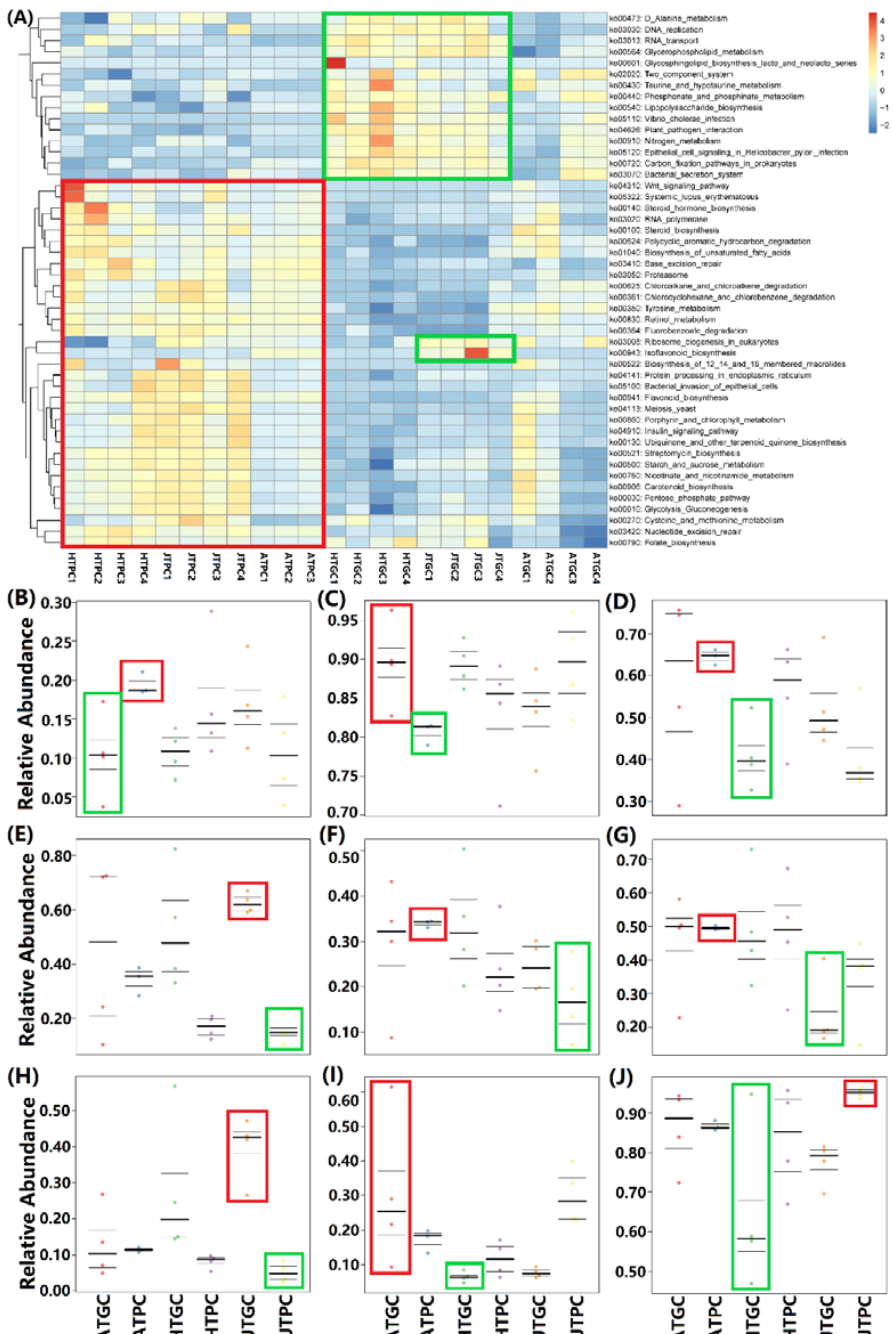
Figure 5. Kyoto Encyclopedia of Genes and Genomes (KEGG) pathway annotation information and prediction of bacterial phenotype of PC and GC groups. ( A ): KEGG pathway annotation, the red and green boxes represent the high abundance of PC and GC environments. The black boxes represent the high abundance of the HTPC group, the blue boxes represent the high abundance of the JTPC group, and the red boxes represent the high abundance of the HTGC group. The green boxes represent the high abundance of the JTGC group, and the gray boxes represent the high abundance of the ATGC group. ( B ): Gram Positive; ( C ): Gram Negative; ( D ): Biofilm Forming; ( E ): Pathogenic Potential; ( F ): Mobile Elements; ( G ): Aerobic; ( H ): Anaerobic; ( I ): Facultative anaerobic; ( J ): Oxidative Stress Tolerant. The red boxes represent the highest relative abundance and the green boxes represent the lowest relative